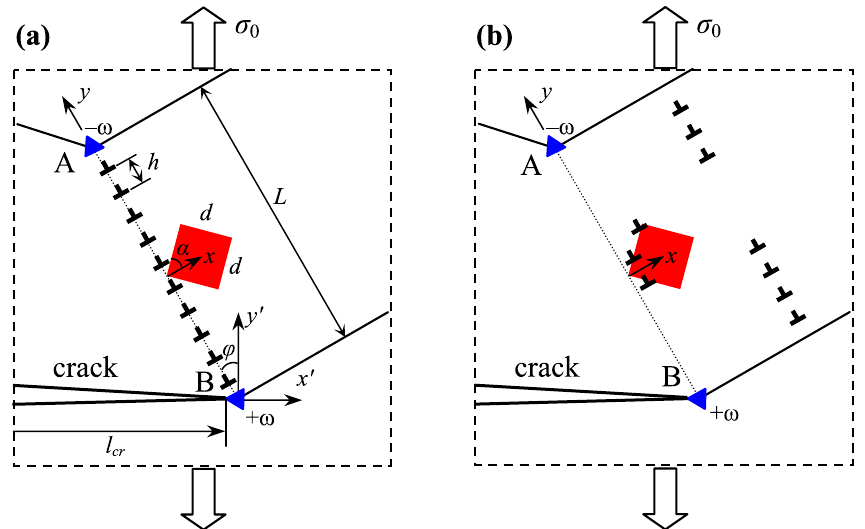
Fig. 2. Migration of a low-angle tilt boundary hindered by an incoherent nanoinclusion impenetrable for dislocations in the vicinity of a crack